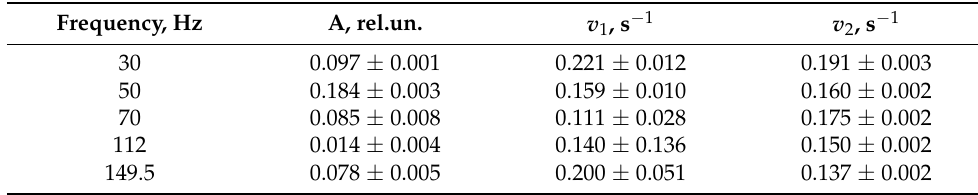
Table 4. Calculated parameters for function